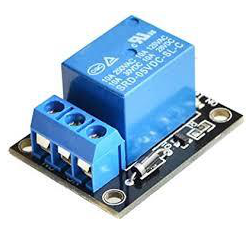
Figure 5 – Relay Рис. 5 – Реле Слика 5 –